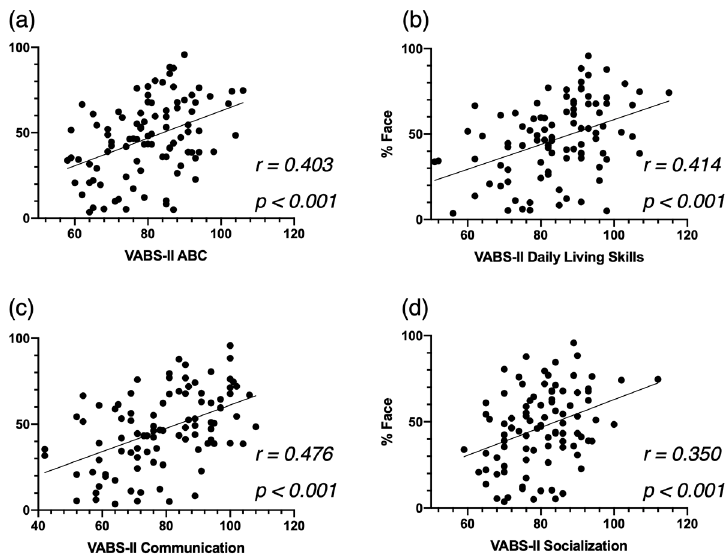
Figure 4. Correlation between %Face and the Vineland Adaptive Behavior Schedule—2nd edition (VABS-II) Adaptive Behavior Composite Score ( a ), the Communication Standardized Score ( b ) and the Socialization Standardized Score ( c ), at baseline for the cross-sectional ASD group, and the Daily Living Skills Standardized Score ( d ).